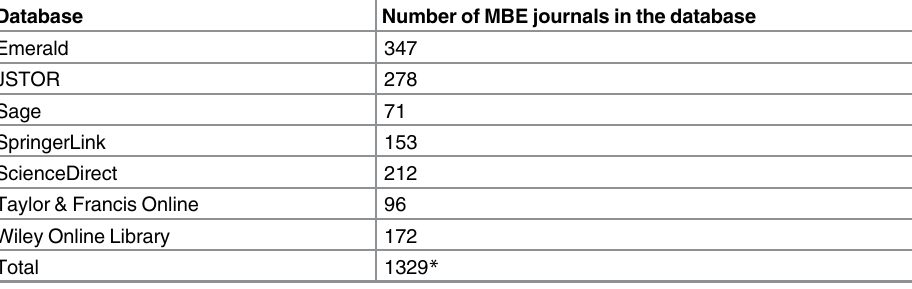
Table 1. List of databases in the retractions search.